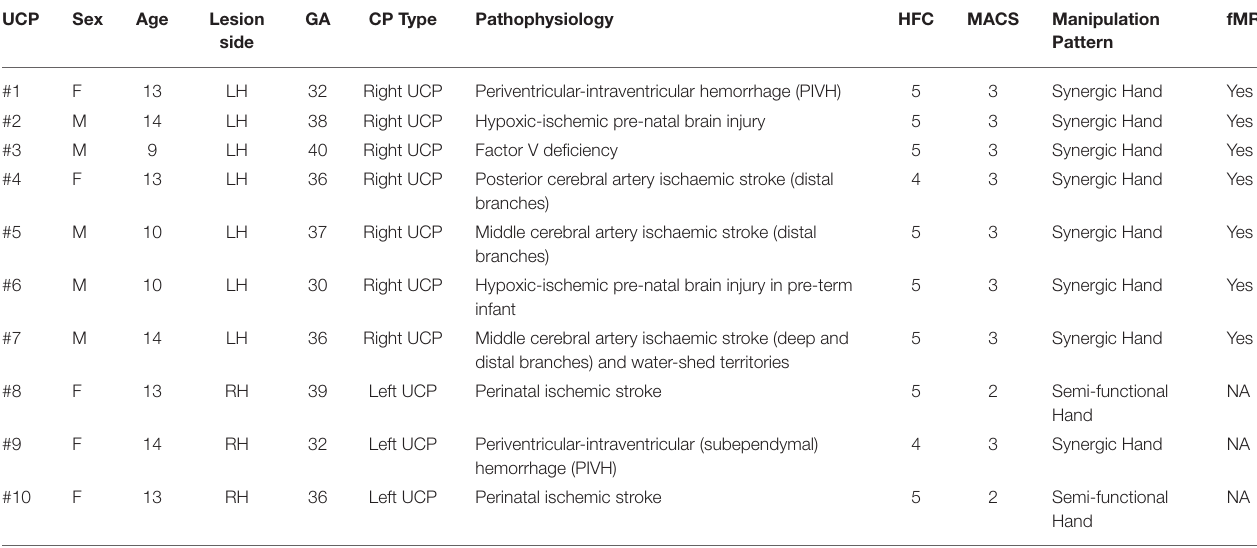
TABLE 1 | Demographic data, clinical features and functional classification in cases